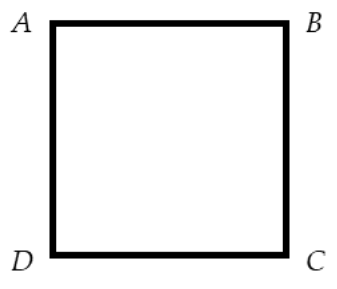
Figure 4. The diagram of four points.